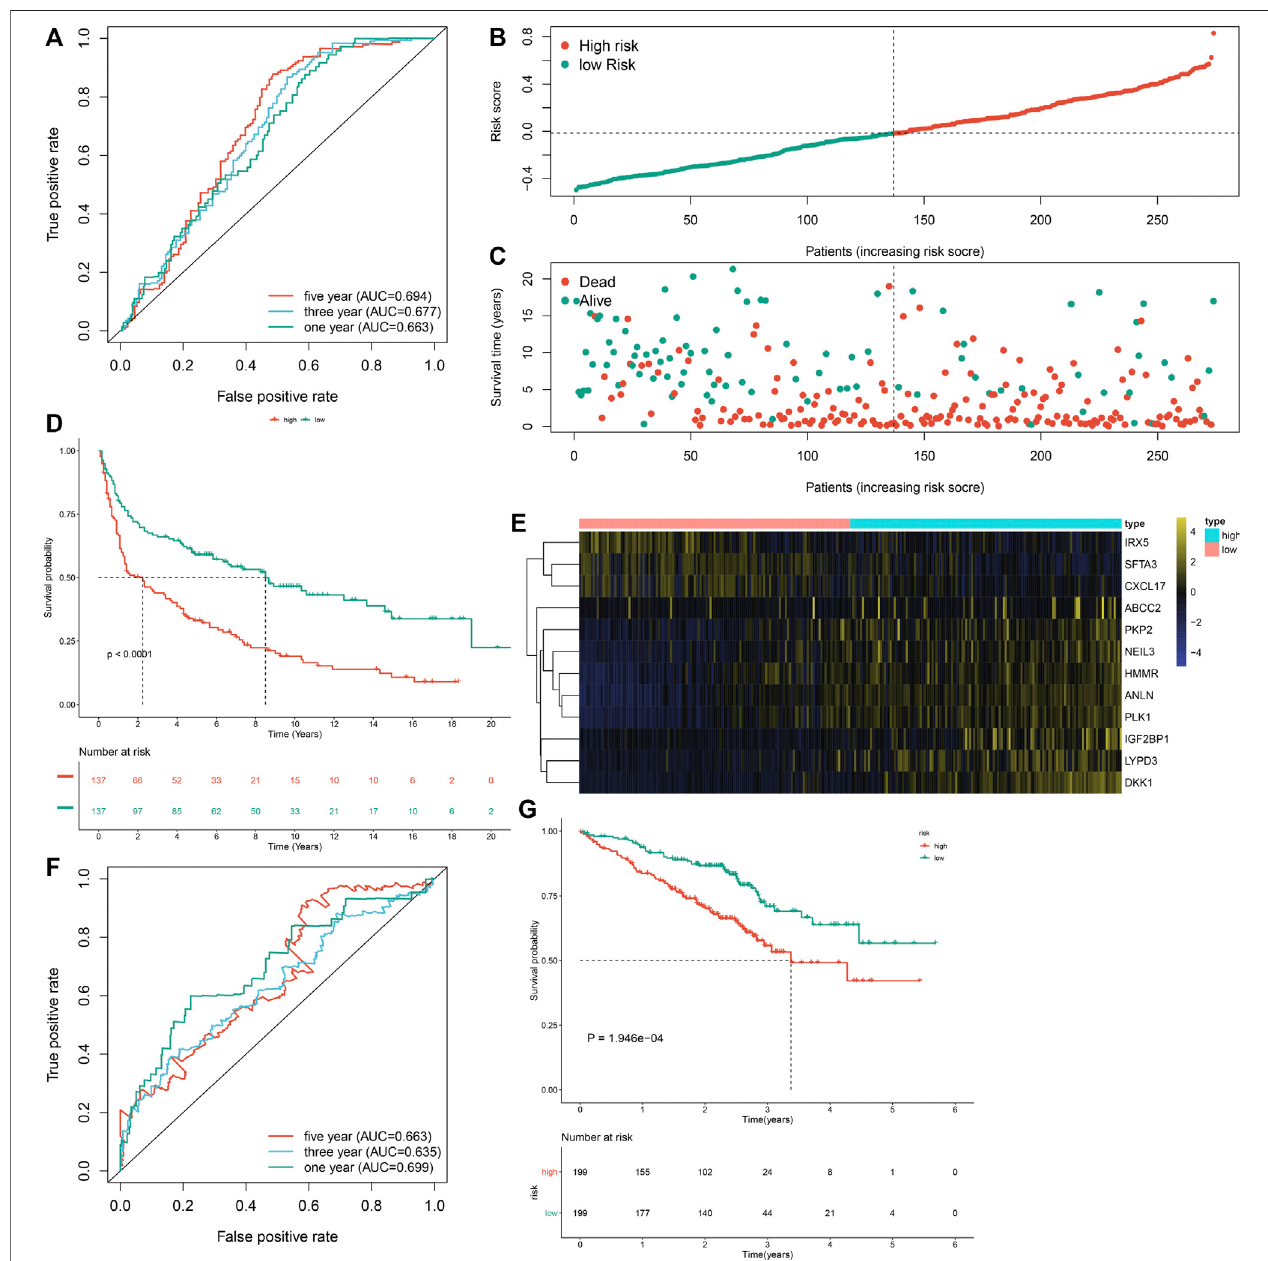
FIGURE 6 | External veri fi cation of the m 6 A risk score for LUAD samples in the GSE30219 and GSE72094 datasets. (A) ROC curves for estimating the ef fi cacy of the m 6 A risk score in prediction of one, three and 5-year OS in the GSE30219 dataset. (B) The distribution of m 6 A risk score and identi fi cation of the median m 6 A risk score indicated by vertical dotted line in the GSE30219 dataset. (C) The distribution of survival status in high- and low-m 6 A risk score groups. Red dots indicated dead status and blue dots indicated alive status in the GSE30219 dataset. (D) Kapan-Meier curves of OS for high- and low-m 6 A risk score groups, followed by log-rank test in the GSE30219 dataset. (E) Hierarchical clustering analysis for the mRNA expression patterns in LUAD samples from high- and low-m 6 A risk score groups in the GSE30219dataset. (F) ROCcurvesforassessingtheef fi cacyofthem 6 Ariskscoreinpredictionofone,threeand5-yearOSintheGSE72094dataset. (G) Kapan-Meier curves of OS for high- and low-m 6 A risk score groups, followed by log-rank test in the GSE72094 dataset.